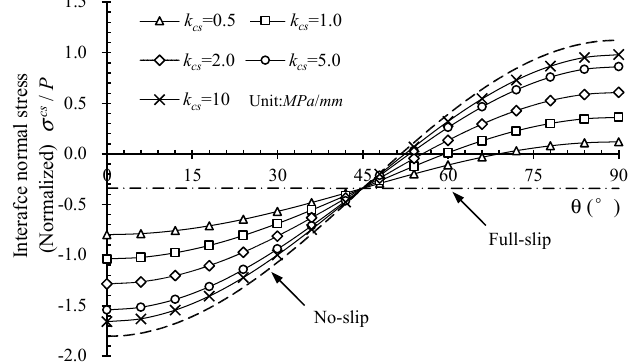
Figure 14. Influence of k cs on the interface normal stress.